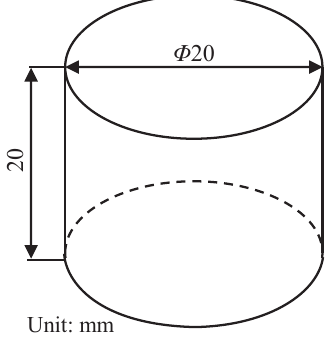
Figure 3. Geometry and dimension of the specimen.